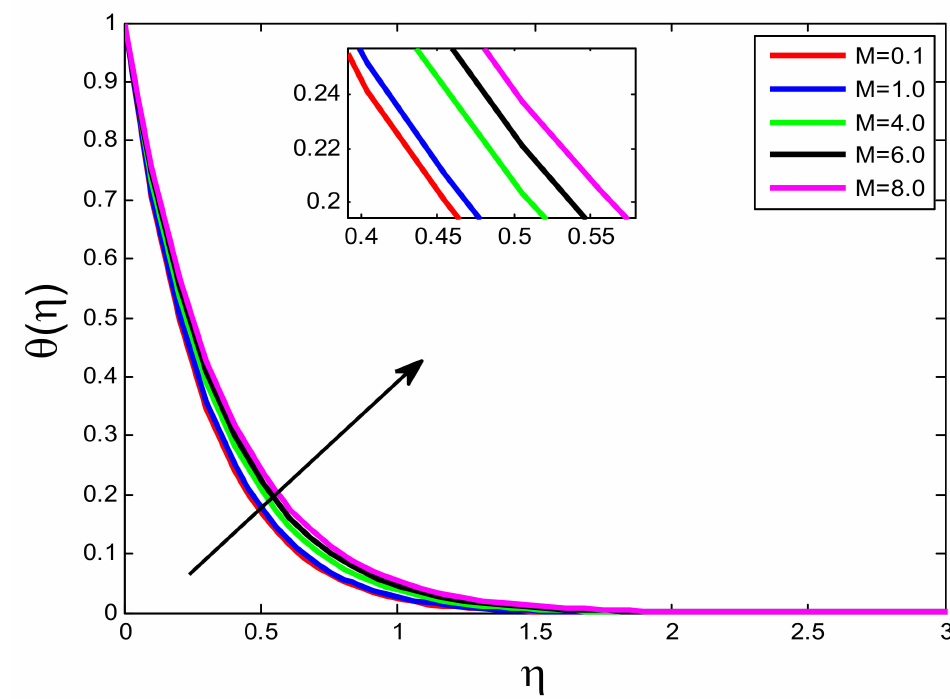
Figure 22. Influence of M on θ ( η ) .